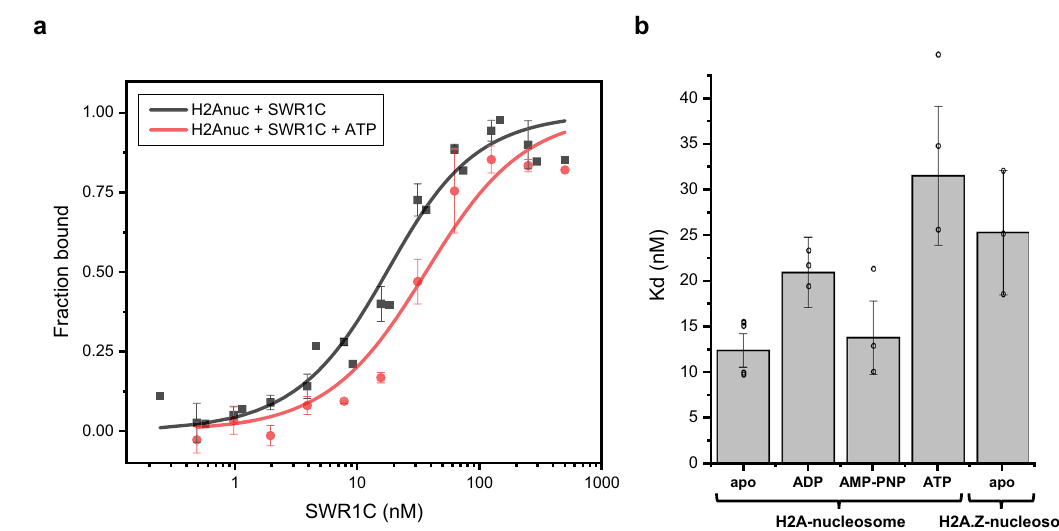
Fig. 5 | Fluorescence polarization assays show that ATP hydrolysis promotes the release of SWR1C from the H2A-nucleosome. a Normalized fl uorescence polarization plots and fi tted curves for titrated SWR1C binding to an H2A nucleo- some without nucleotide (black) or in the presence of 1mM ATP (red). Each curve representsaglobal fi tof3replicateswiththestandarderror(+/ − SEM)indicatedby